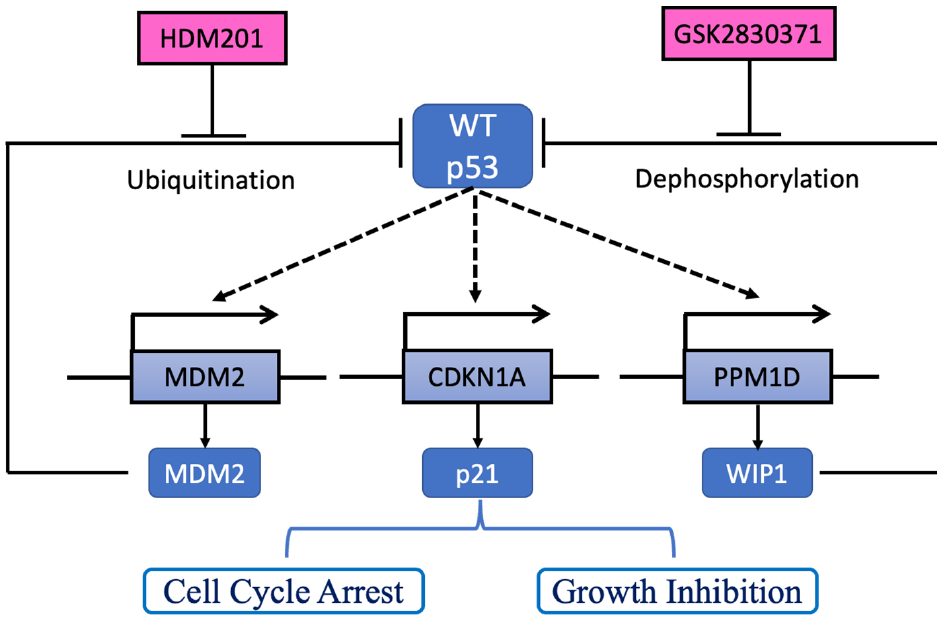
Figure 7. Proposed model for GSK2830371 (WIP1i) potentiation of the growth-inhibitory effects of HDM201. p53 transactivated targets (dashed lines), MDM2 and PPM1D encoding MDM2 and WIP1, which, respectively, suppress p53 function via ubiquitination and dephosphorylation. In addition, p53 transactivates other targets such as CDKN1A encoding p21 WAF1 which induces cell cycle arrest and growth inhibition. MDM2 inhibitor, HDM201, blocks the p53-MDM2 binding interaction, resulting in p53 stabilization. WIP1 inhibition (WIP1i), GSK2830371, increases phospho-p53 (Ser 15) through allosteric inhibition of WIP1 phosphatase. Both inhibitors work on p53 and together achieve greater growth inhibition and cell killing. Dashed lines indicate p53 transcriptional upregulation of the corresponding genes.